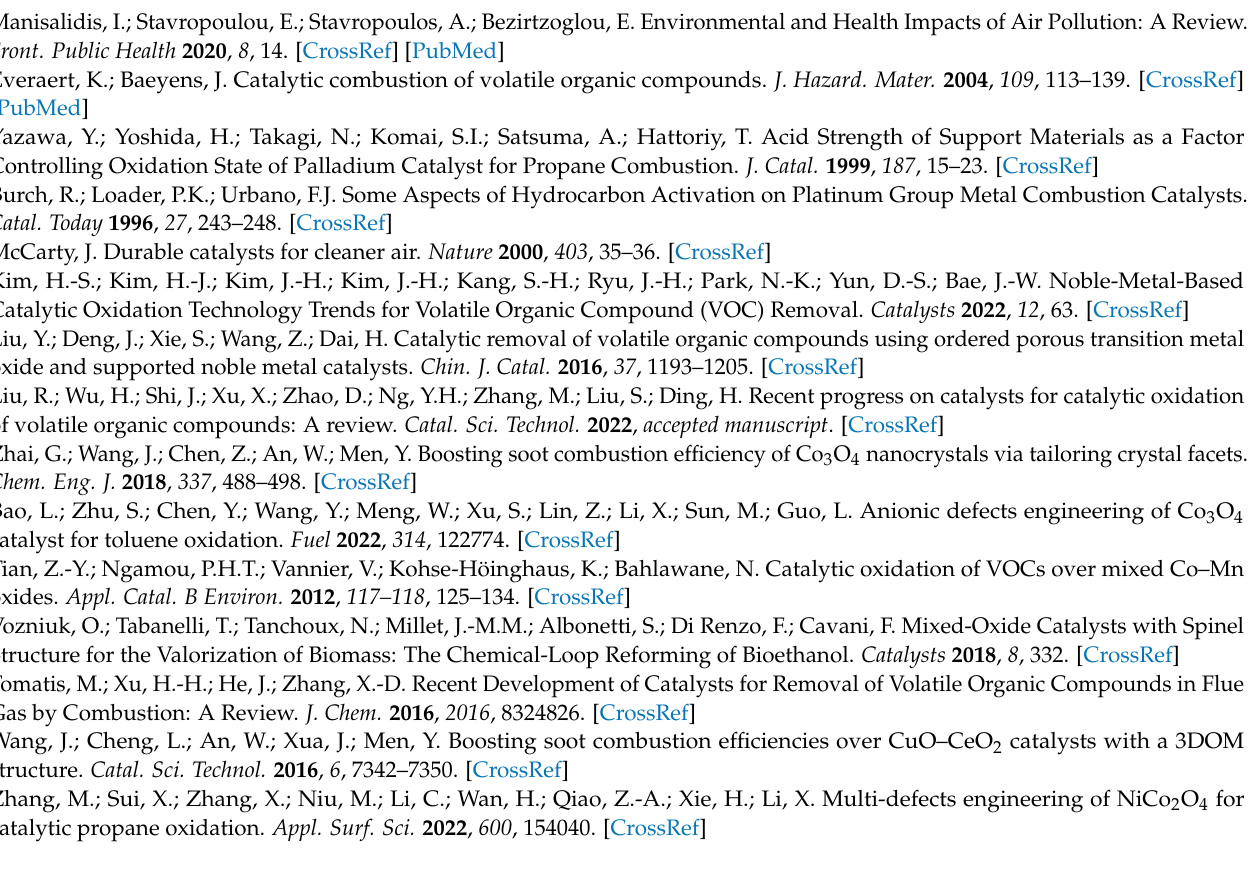
the calculated, lower blue and black line-calculated and grey line-difference plot; Figure S5: Rietveld plot of the MCF-CA using two spinel phase. Upper blue line—experimental, red line—sum of